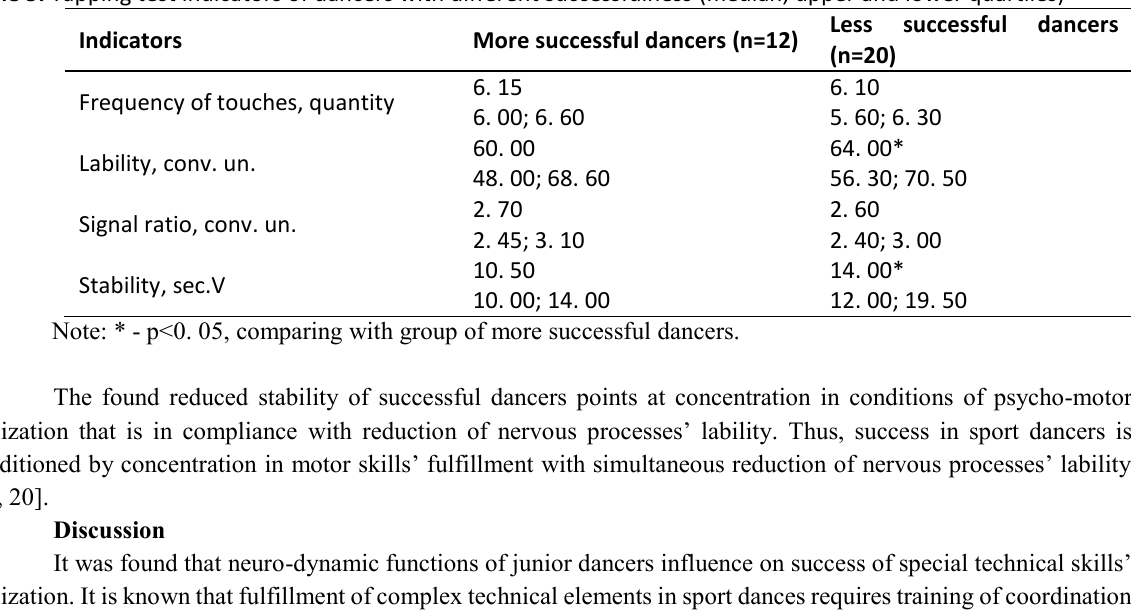
Table 5. Tapping test indicators of dancers with different successfulness (median, upper and lower quartiles) Indicators More successful dancers (n=12) Frequency of touches, quantity Lability, conv. un. Signal ratio, conv. un. Stability, sec.V